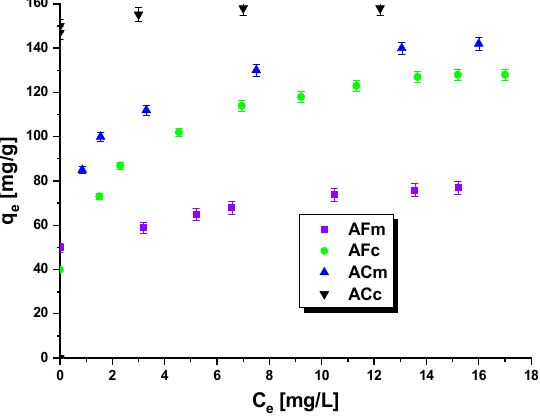
Figure 3. Adsorption of methyl red sodium salt onto biocarbons. The methyl red sodium salt adsorption from its water solutions was interpreted assum- ing the linear forms of the Langmuir and Freundlich equations (Table 4, Figure 4a,b) [31]. The Langmuir model of adsorption is based on the assumption that on the adsorbent surface of the adsorbate a monomolecular layer is formed. It would mean that the sur- face of biocarbons has a certain number of active centers that are able to adsorb only one molecule of the adsorbate [32]. The Langmuir isotherm is represented by the following linear Equation (1):